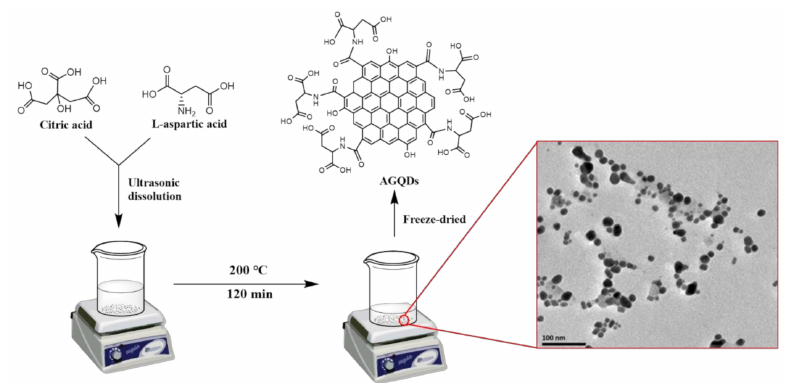
Figure 1. Scheme of the synthetic process of AGQDs.